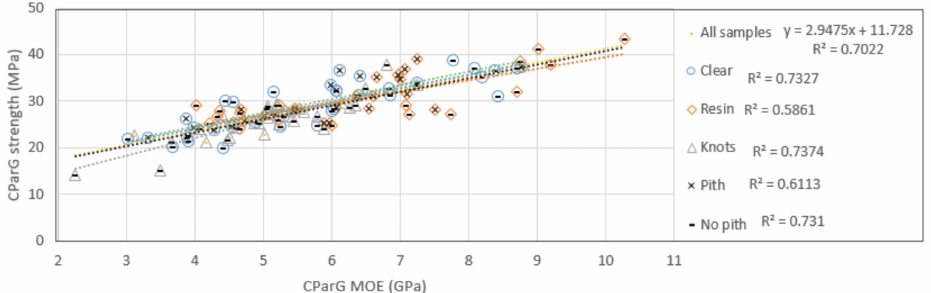
Figure 17. Relationship of CParG MOE and